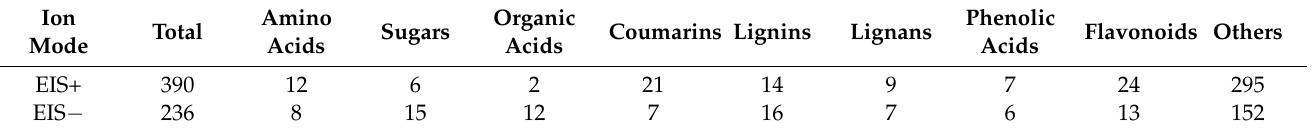
Table 1. Identification and composition of metabolites in the apricot endocarp.